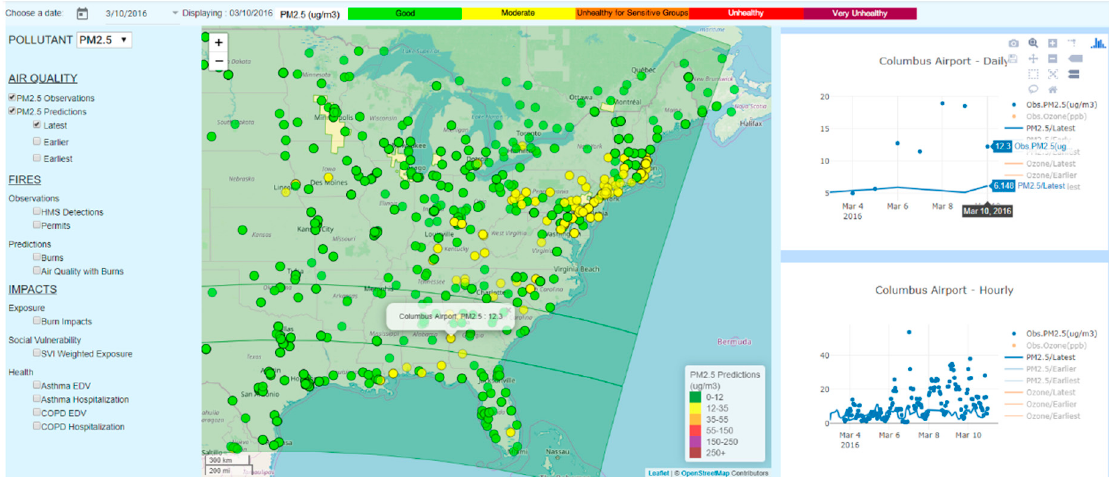
Figure A1. The SIPFIS webpage displays, as an example, PM 2.5 observations for 10 March 2016, overlaid with the latest PM 2.5 forecasts, as well as the time series for the monitoring site at